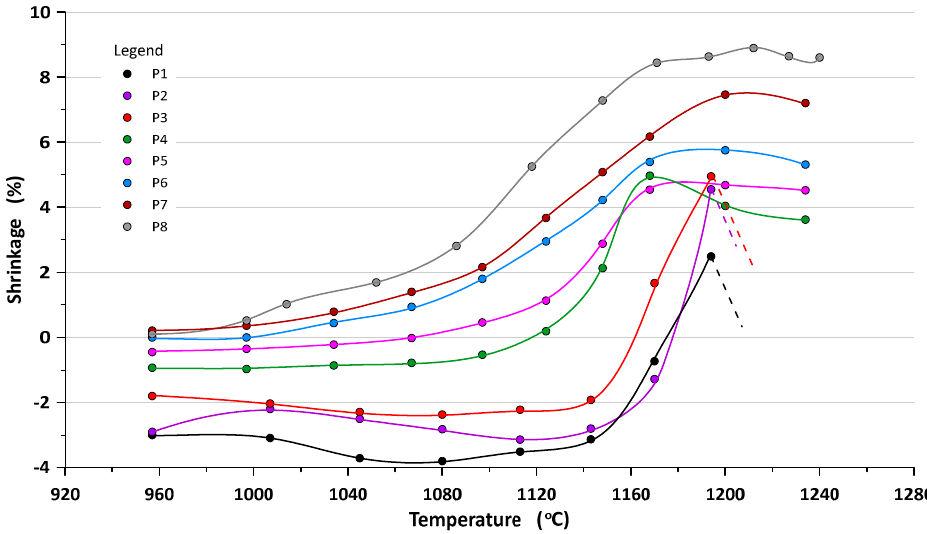
Figure 4. Shrinkage as a function of firing temperature.